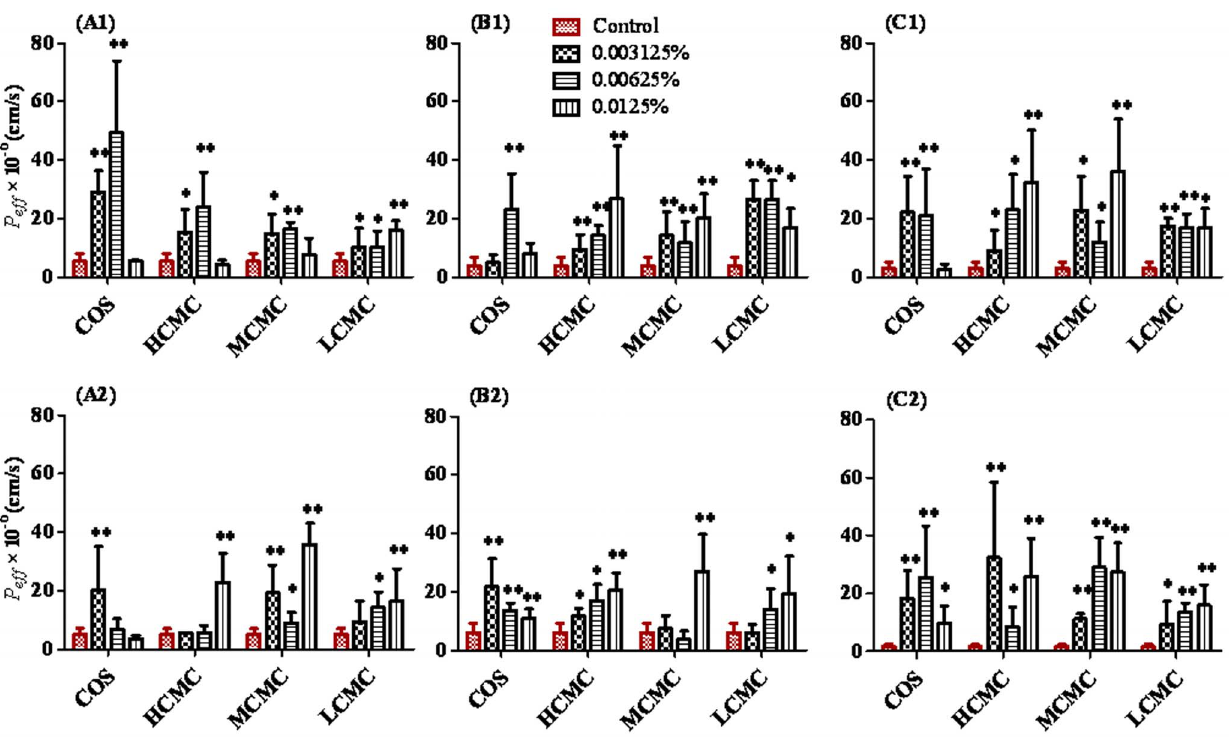
Figure 4. Effects of CMCs and COS on absorption parameters of FTA and CHA in rat single pass intestinal perfusion via duodenum (A), jejunum (B) and ileum (C) insitu model. Results are expressed as the mean 6 S.D. ( * ) P , 0.05 and ( ** ) P , 0.01 compared with the control group (A1, B1, C1: FTA; A2, B2, C2: CHA).